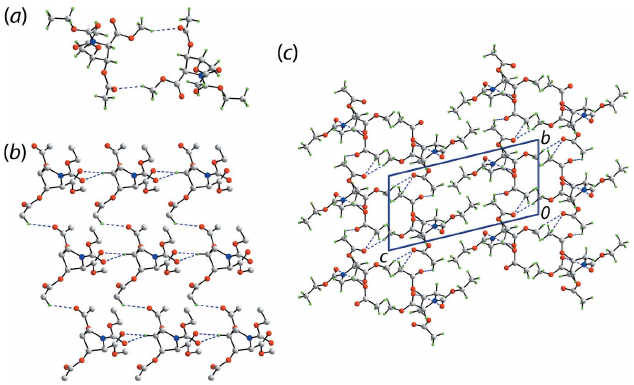
Figure 2 Molecular packing in (II): ( a ) supramolecular dimer sustained by methyl- C9—H (cid:3)(cid:3)(cid:3) O5(carbonyl) contacts, ( b ) layer sustained by methyl-C11— H (cid:3)(cid:3)(cid:3) O7(carbonyl) and bifurcated methylene-C3—H (cid:3)(cid:3)(cid:3) O1,O3(carbonyl) contacts (non-participating H atoms are omitted) and ( c ) a view of the unit-cell contents shown in projection down the a axis. The C—H (cid:3)(cid:3)(cid:3) O interactions are shown as blue dashed lines.